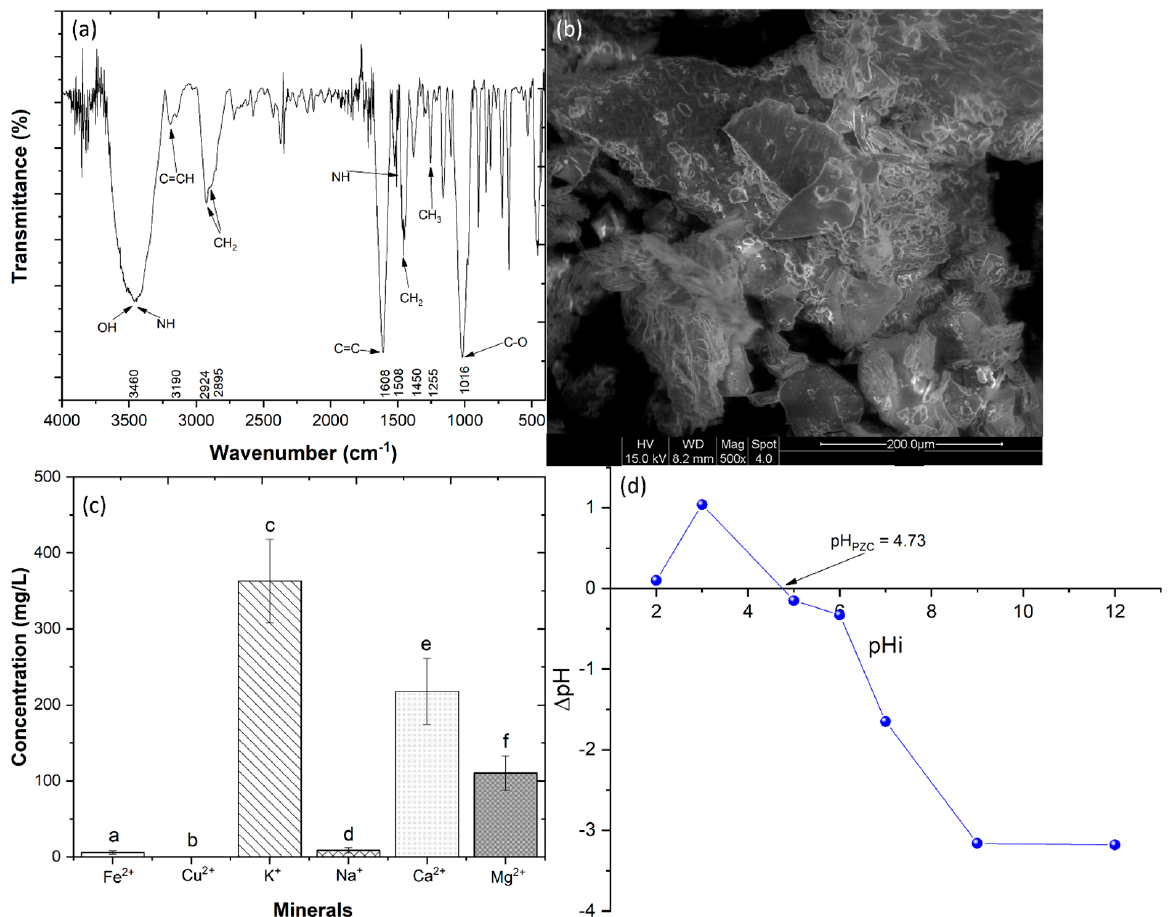
Figure 1. Almond skin powder characterization: ( a ) FTIR spectrum, ( b ) SEM image (500×), ( c ) mineral analysis and ( d ) pH PZC of almond powder. The pHi is the initial pH value of the solution, and ∆ pH is the difference between final pH values (after contact with the AP) and pHi values. Means in bars with different letters represent significant differences ( p < 0.05) between different minerals.